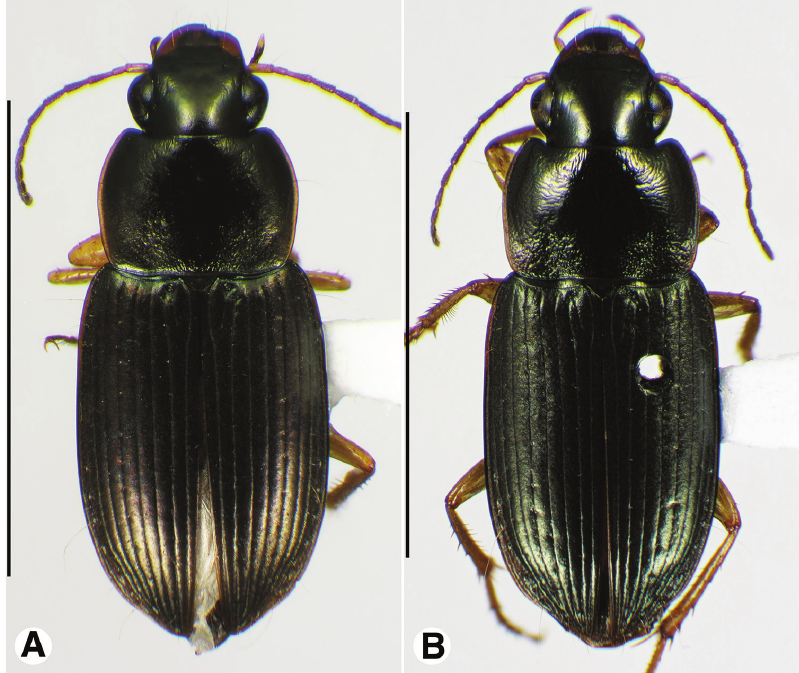
Figure 14. Habitus digital images of Selenophorus discopunctatus species group, dorsal aspect. A S. discop- unctatus Dejean B S. yucatanus Putzeys. Scale bars 5